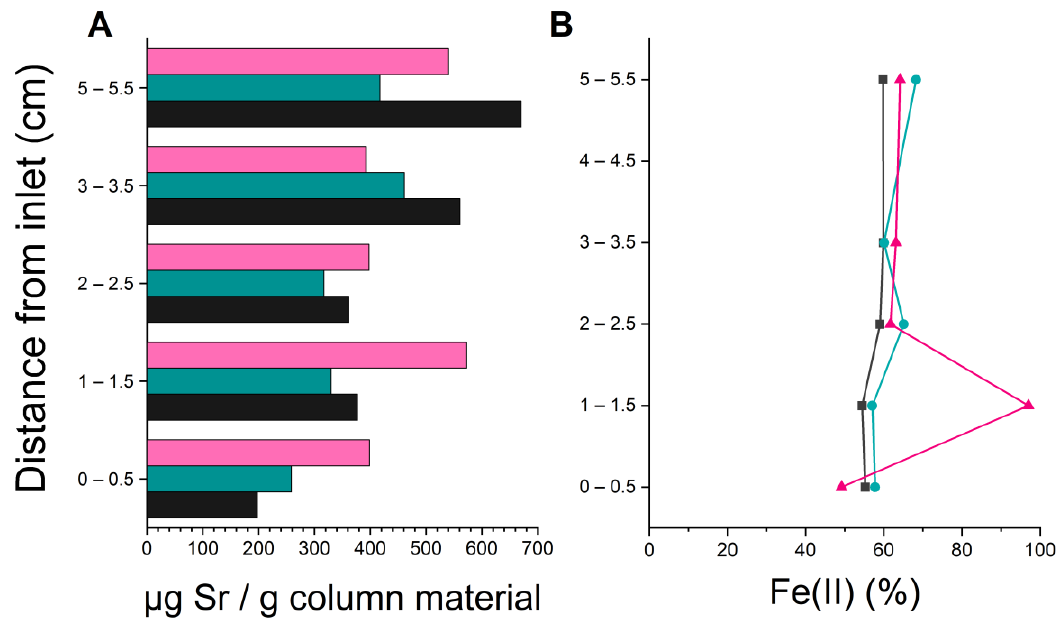
Figure 2. ( A ) Concentration of Sr and ( B ) 0.5 N HCl extractable Fe(II) expressed as a % of total 0.5 N HCl extractable Fe from selected column material samples (0.5 cm depth increments) from the three column systems: ( black squares ) rock flour, ( green circles ) rock flour + bentonite (6 wt.%), and ( pink triangles ) rock flour + bentonite (6 wt.%) + steel coupons. Sr present in starting materials was subtracted before plotting (Supplementary Materials Table S2). The steel coupons were added at a distance of 1.5 cm from the